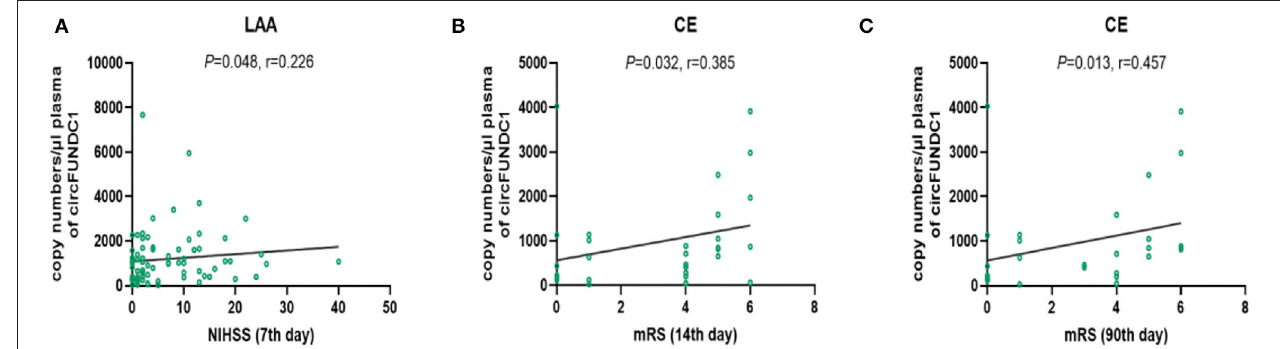
FIGURE 3 | The relationship between circFUNDC1 levels and NIHSS scores and mRS scores in acute ischemic stroke (AIS) patients. The scatterplot showed circFUNDC1 levels were positively associated with NIHSS scores on the 7th day in LAA stroke patients (A) , mRS scores on the 14th day (B) , and the 90th day (C) in